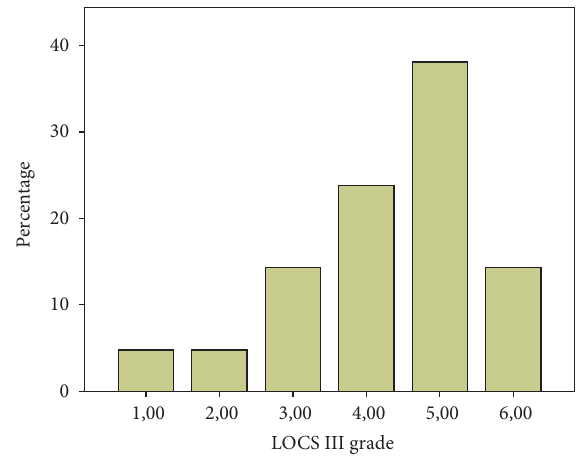
Figure 2: Histogram classifying the type of cataract according to the LOCS III system; this figure shows that 1 (4.8%) was of grade 1, 1 (4.8%) was of grade 2, 3 (14.3%) were of grade 3, 5 (23.8%) were of grade 4, 8 (38.1%) were of grade 5, and 3 (14.3%) of were grade 6.